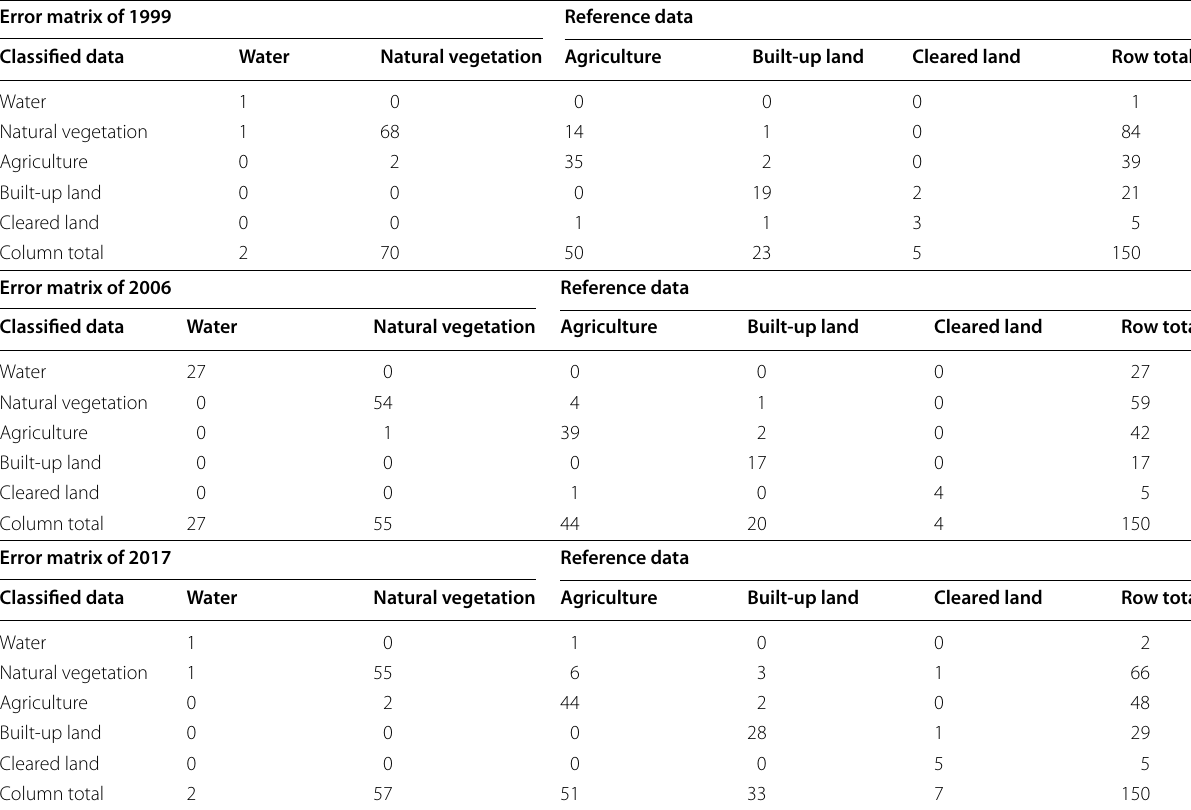
Table 3 Error matrix for the land cover maps 1999, 2006, and 2017, showing the accuracy of the land cover maps